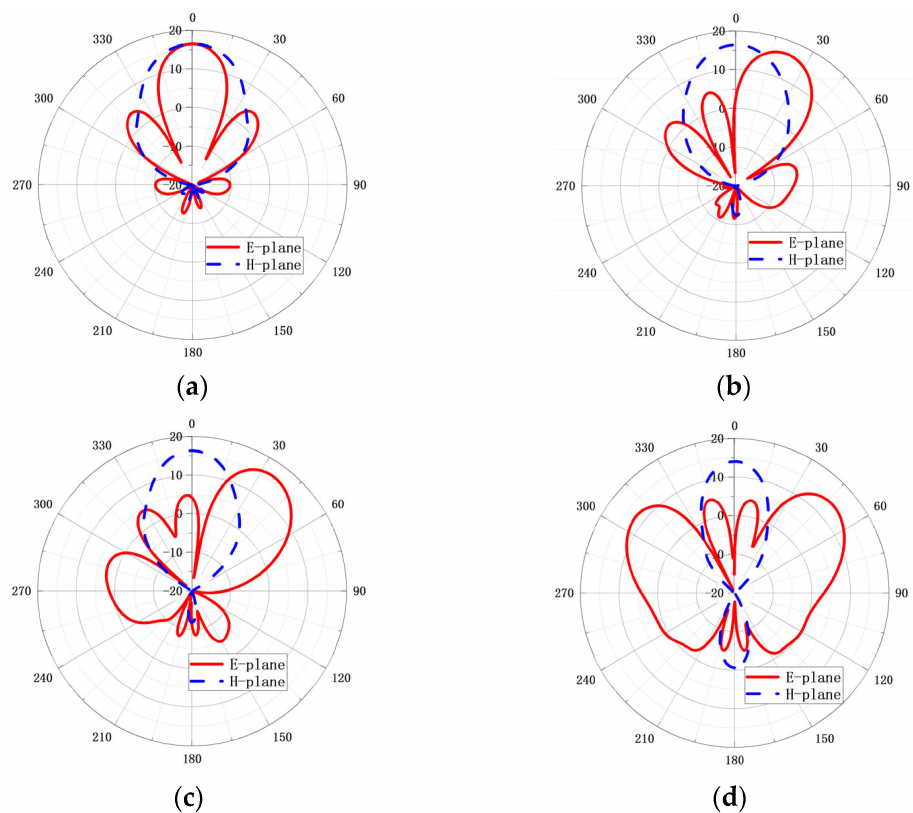
Figure 3. The simulated radiation patterns of the proposed H-plane horn array antenna at 94 GHz, ( a ) the radiation pattern for 0 ◦ tilt-angle; ( b ) the radiation pattern for 20 ◦ tilt-angle; ( c ) the radiation pattern for 35 ◦ tilt-angle; ( d ) the radiation pattern for 45 ◦